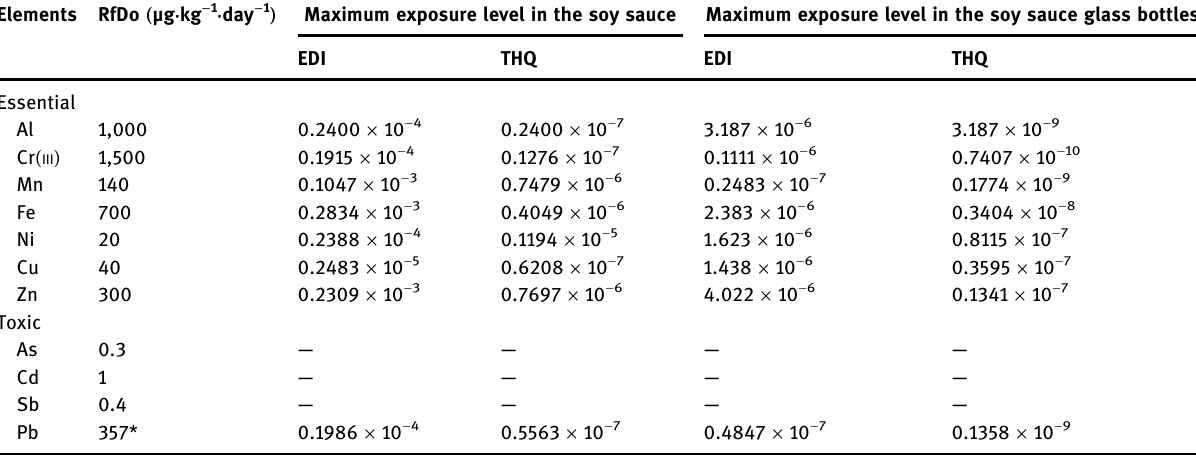
Table 8: EDI and THQ of trace elements due to the soy sauce and glass bottles Elements RfDo ( µg · kg − 1 · day − 1 ) Maximum exposure level in the soy sauce Maximum exposure level in the soy sauce glass